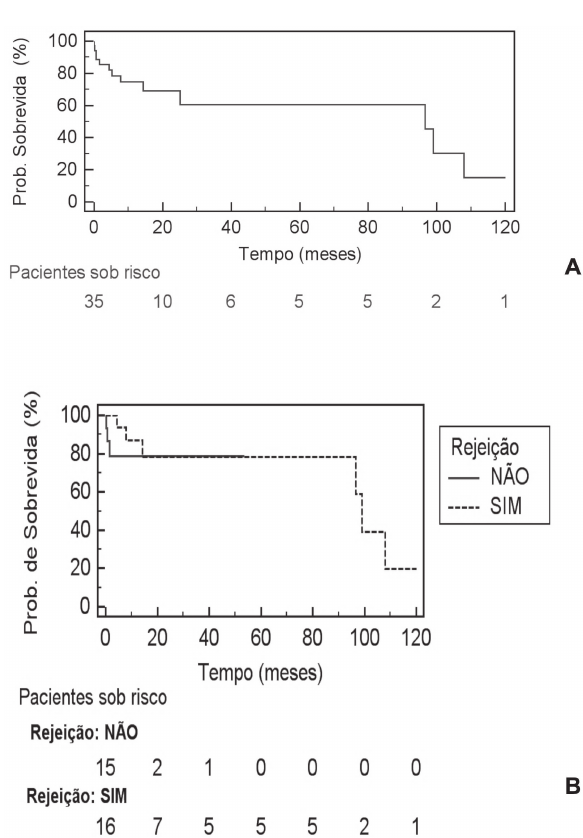
Fig. 1 – A: Sobrevida geral dos pacientes submetidos a transplante após 10 anos de seguimento. B: Sobrevida dos pacientes divididos em pacientes que não apresentaram nenhum episódio de rejeição e pacientes que apresentaram pelo menos um episódio de